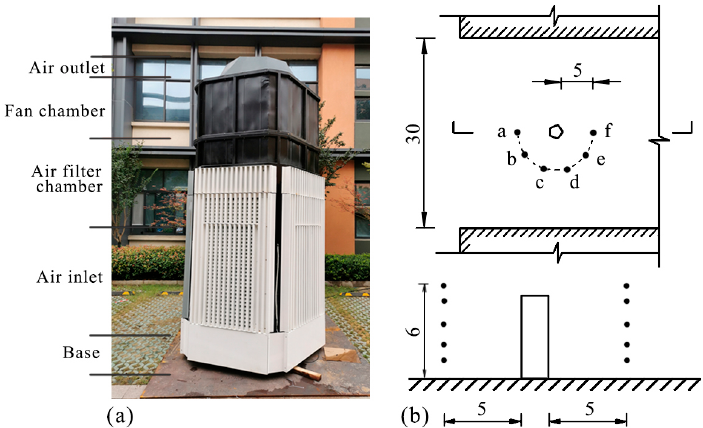
Figure 1. ( a ) A photograph of the ambient air filter examined in this study; ( b ) schematic diagrams of noise measurements of the filter tower (unit: m).